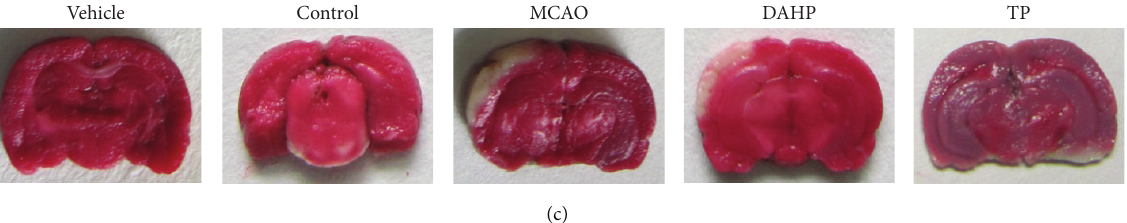
Figure 1: The representative images of TTC staining and MRI outcome show the effects of DAHP and TP on MCAO-induced focal cerebral ischemia in rats. (a) Mean change in infarction volume is significant in MCAO group (MCAO), DAHP treatment group (DAHP), and TP treatment group (TP) in comparison with the normal control (control). Infarction area was less in the treatment groups than the MCAO group, thus presenting their neuroprotective effects. Data is expressed as means ± SEM ( 𝑛 = 5 –10); ∗ 𝑃 < 0.05 , ∗∗ 𝑃 < 0.01 , and ∗∗∗ 𝑃 < 0.001 compared with normal control. (b) Compared with vehicle group (vehicle) and control, the images show hyperintensity in MCAO, DAHP, and TP, among which MCAO has the largest hyperintensity areas. (c) The images of TTC staining in each group show the same tendency of ischemia infarction as the MRI results; DAHP and TP attenuate cerebral ischemia. TTC staining results revealed that the differences in infarction areas were significant in rats pretreated by DAHP and TP, which is consistent with MRI results.